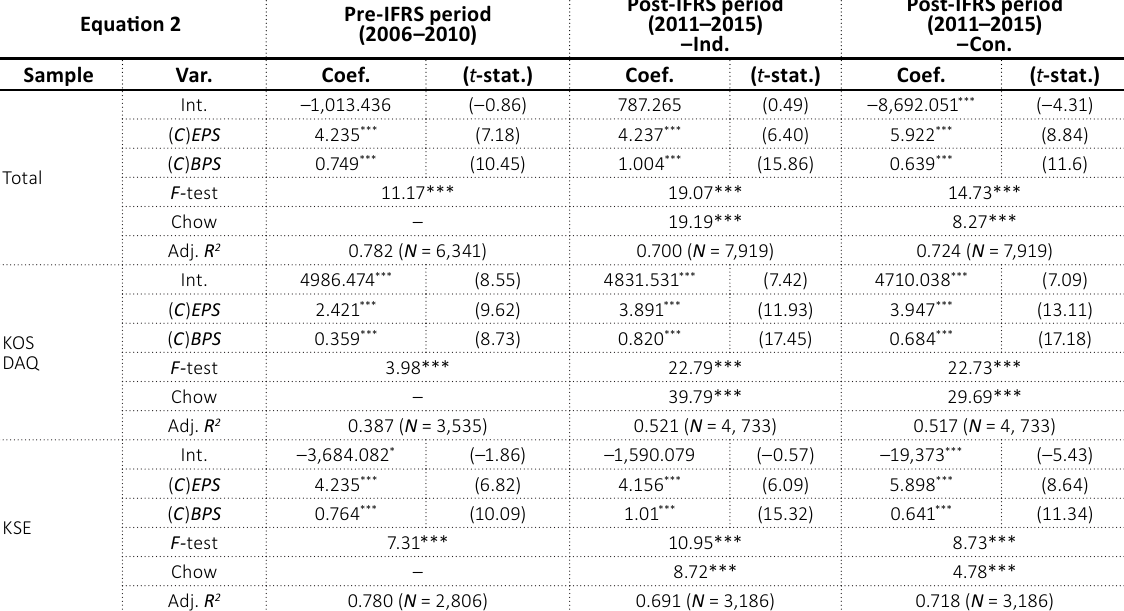
Table 4. Test results of hypothesis using fixed industry effect model (Equation (2)) Equation